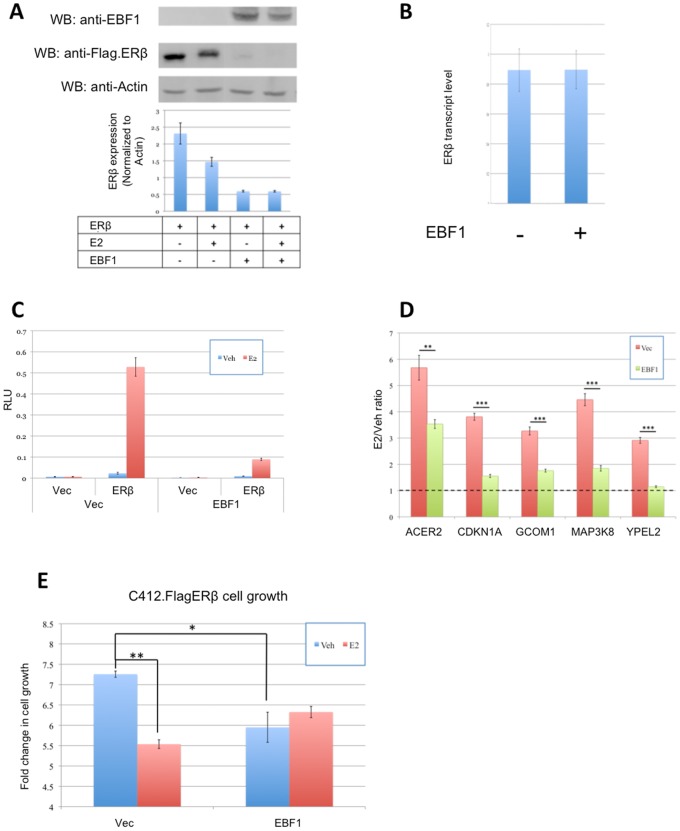
EBF1 negatively regulates ERβ protein levels and downstream activity.MCF-7/C4–12 cells were transfected with Flag.ERβ in the presence or absence of EBF1 and then treated with E2 or Vehicle control. (A) Flag.ERβ protein and (B) mRNA levels were measured on Western blots and by RT-qPCR, respectively. ERβ transcriptional response was measured in an (C) ERE-Luciferase reporter assay as well as (D) by endogenous target gene regulation. (E) C4–12/Flag.ERβ cells were transfected with EBF1 (or pcDNA3.1(-) as Vector control) and treated with E2 for 3 days. Cell confluency, detected by the Incucyte FLR, was used to measure cell proliferation. The bar graph represents the fold change relative to day 0. Error bars represent standard deviation.